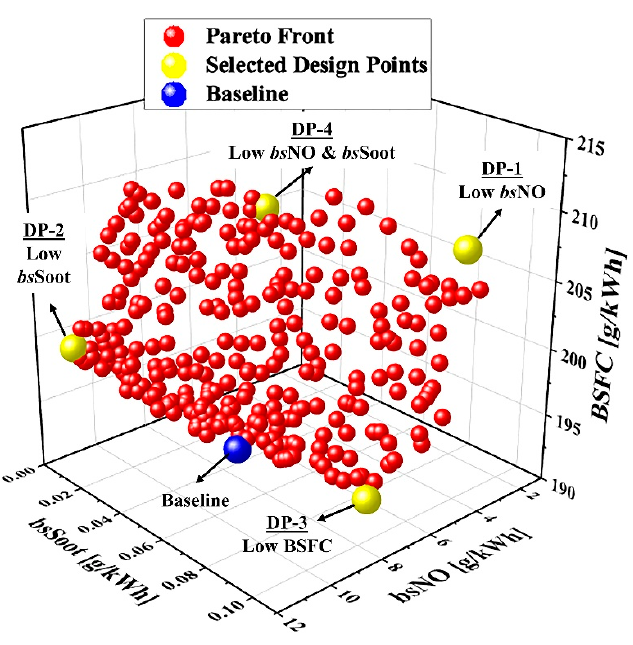
Figure 17. bsNO—bsSoot—BSFC pareto front and selected optimum design points . Figure 17. bs NO— bs Soot—BSFC pareto front and selected optimum design